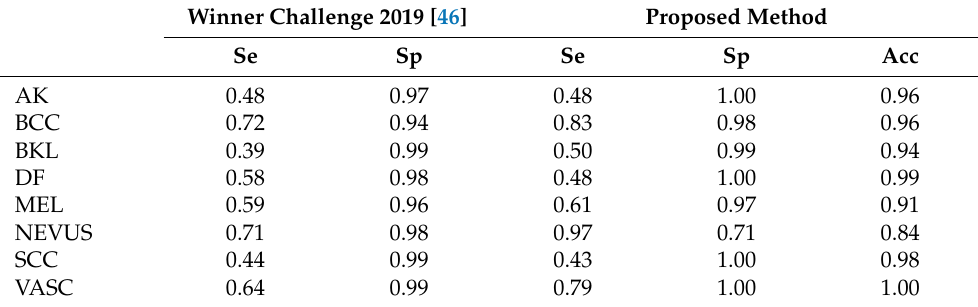
Table 7. Performance parameters for the winner of the ISIC Challenge 2019 [46] and for the proposed method (Argmax ensemble without previous segmentation) when classifying into eight types of lesions. Se: Sensitivity, Sp: Specificity, Acc: Accuracy. Winner Challenge 2019